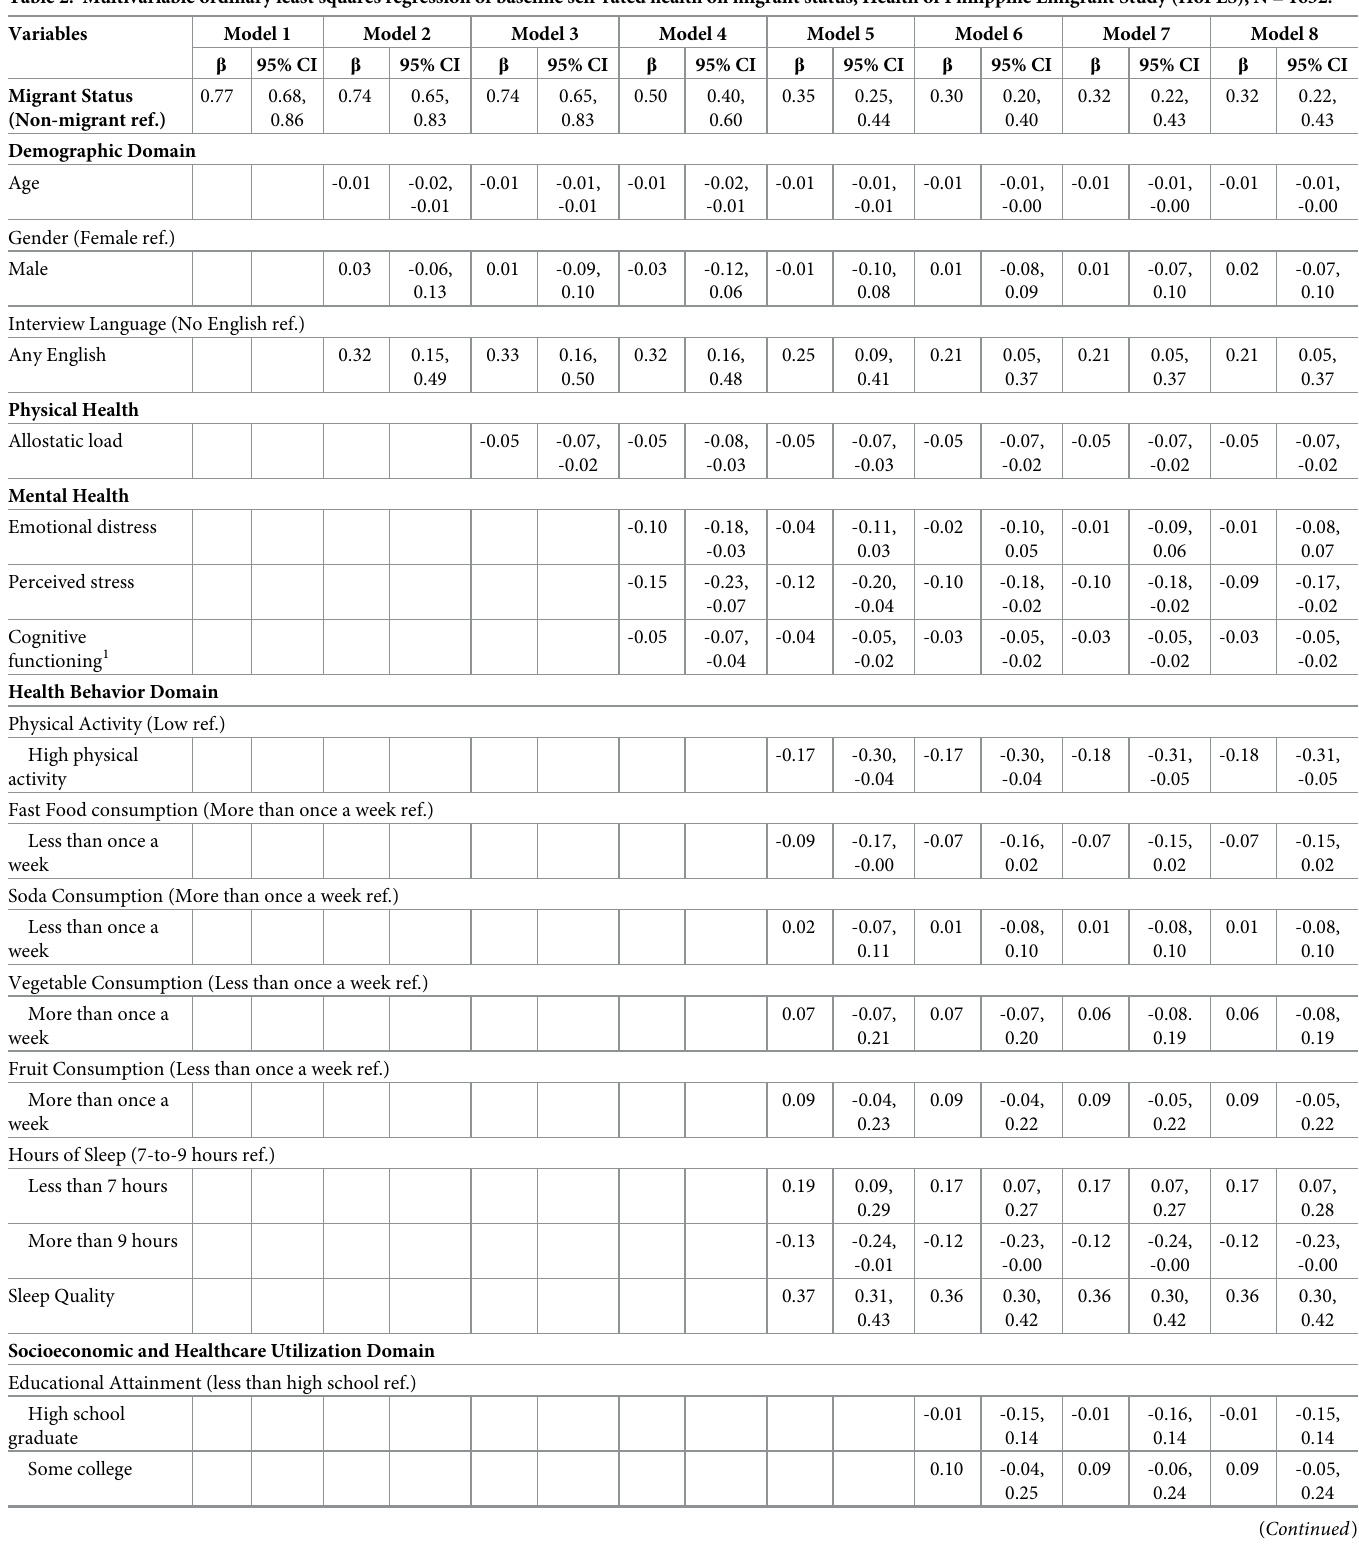
Table 2. Multivariable ordinary least squares regression of baseline self-rated health on migrant status, Health of Philippine Emigrant Study (HoPES), N =